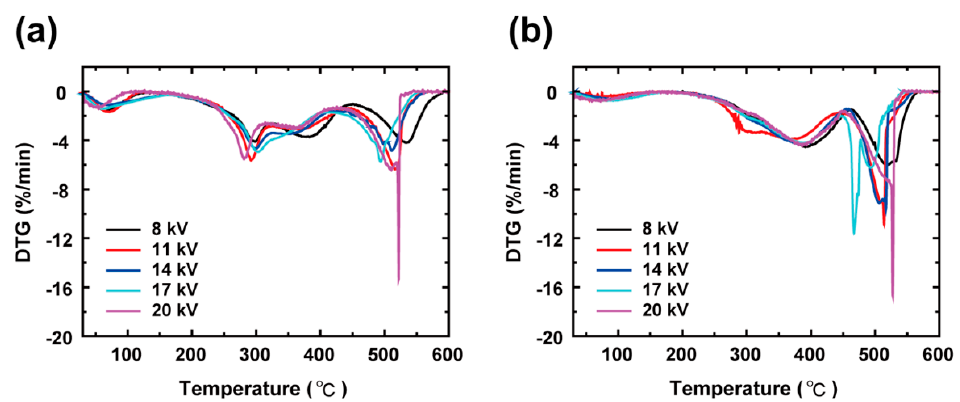
Figure 2. Derivative thermogravimetric (DTG) curves for ( a ) as-spun PAA and ( b ) XLPAA NFs for various electrospinning voltages. The first weight losses, which occurred at approximately 100 °C, originated from the evaporation of the bound water. After crosslinking, the thermal decomposition was retarded from 290 to 390 °C due to the formations of intra- and intermolecular anhydrides. The chain scission for both as-spun PAA and XLPAA NFs occurred above 450 °C.